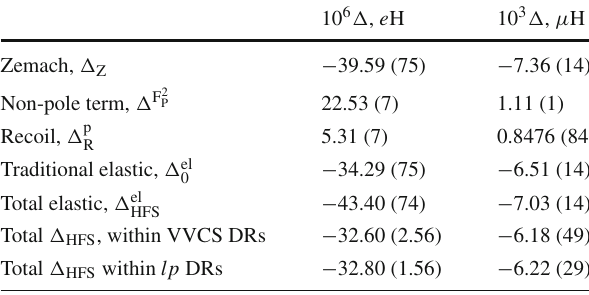
Table1 Finite-sizeTPEcorrectiontothehyperfinesplittingofSenergy levels in e H and μ H. The Fermi energy HFS is 5 . 86785 µ eV for the 1S level in e H and 182 . 4432 meV for the 1S level in μ